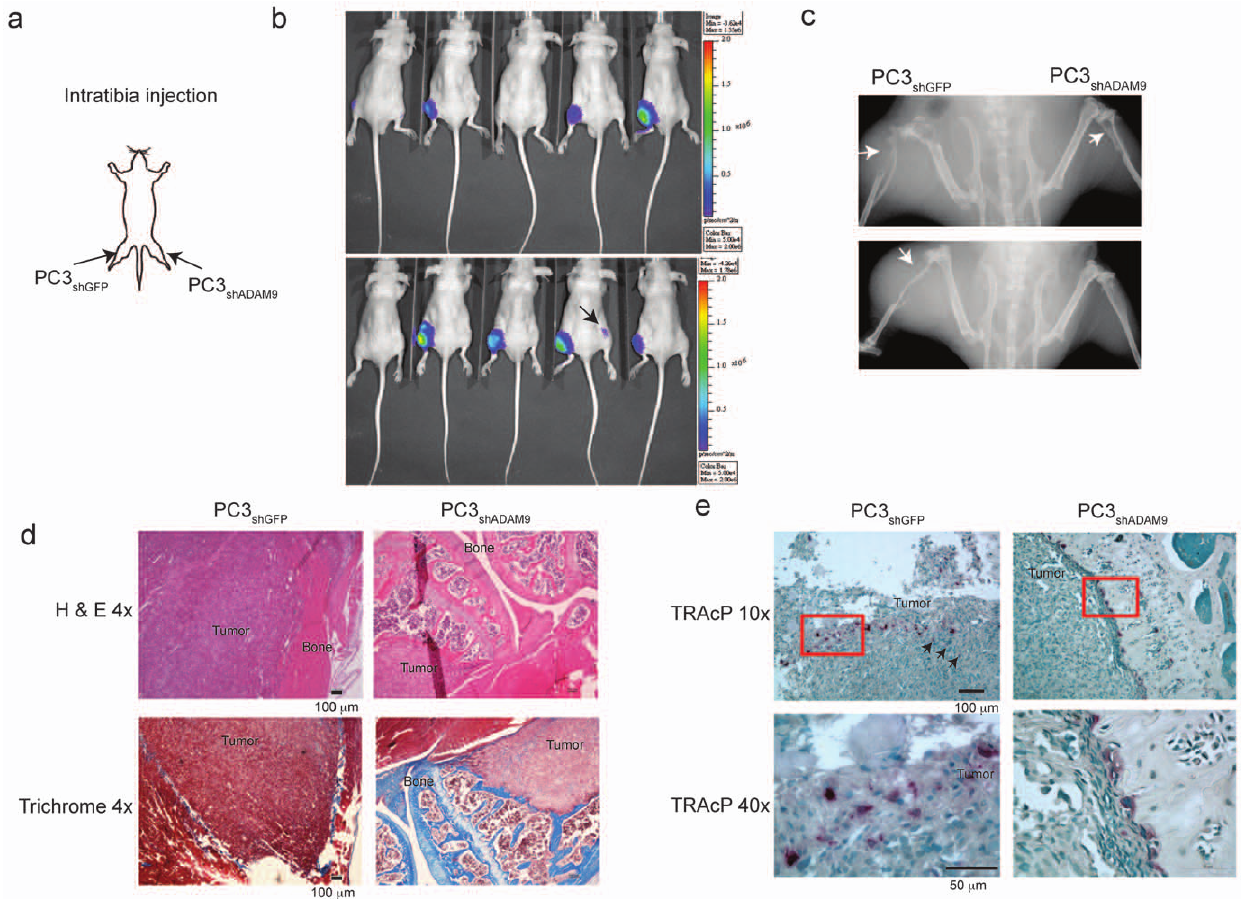
Figure 2. ADAM9 knockdown reduces PC3-induced tumor growth and osteolytic activity. (a) PC3 shGFP and PC3 shADAM9 were injected into the left and right tibia of the same mouse (n=10). (b) Bioluminescence imaging at 40 days post-inoculation. Black arrows show the only signal detected in a PC3 shADAM9 bone lesion. (c) Computerized radiographic scanning of lesion area. Upper image: Bone destruction is extensive in the left leg compared to the right leg; Lower image: mouse with a destructive bone lesion in the left leg and no lesion in the right leg. (d) Histological imaging showing that both trabecular and cortical bone was replaced by the PC3 shGFP tumor. In contrast, trabecular and cortical bone was still intact in the PC3 shADAM9 tumor (H & E). Masson’s trichrome staining indicated only traces of bone left in PC3 shGFP compared to PC3 shADAM9 tumors (Trichrome). (e) TRAcP analysis of osteoclast activity. Arrow indicates osteoclasts observed in a PC3 shGFP tumor. Red highlight indicates loci of 40 6 enlarge.